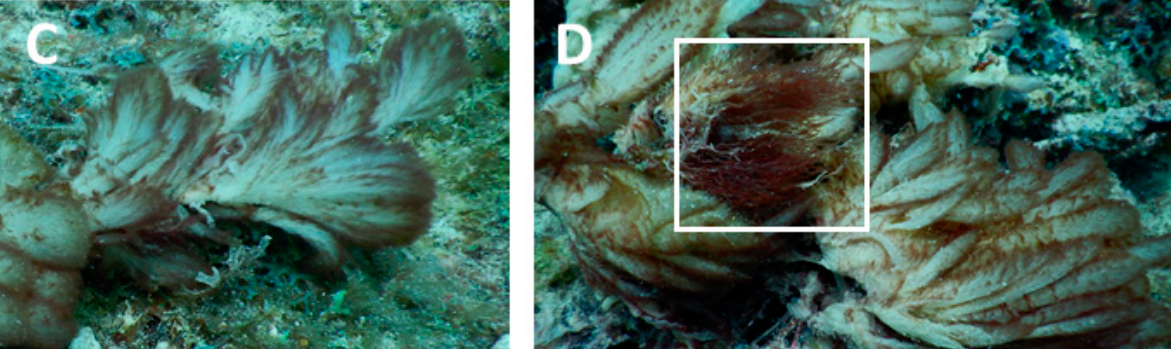
Figure 3. Underwater photographs of Caldora sp. in comparison to Caldora penicillata on the reef near Fort Lauderdale, FL. ( A , B ) Macroscopic photographs of tufts of Caldora sp. Note the distinct mor- phology of Caldora sp., as the filaments are intertwined giving it a “stringy” appearance. ( C ) Caldora penicillata [10]. ( D ) The two species can also grow together, and the white box shows Caldora sp. as it overgrows Caldora penicillata.